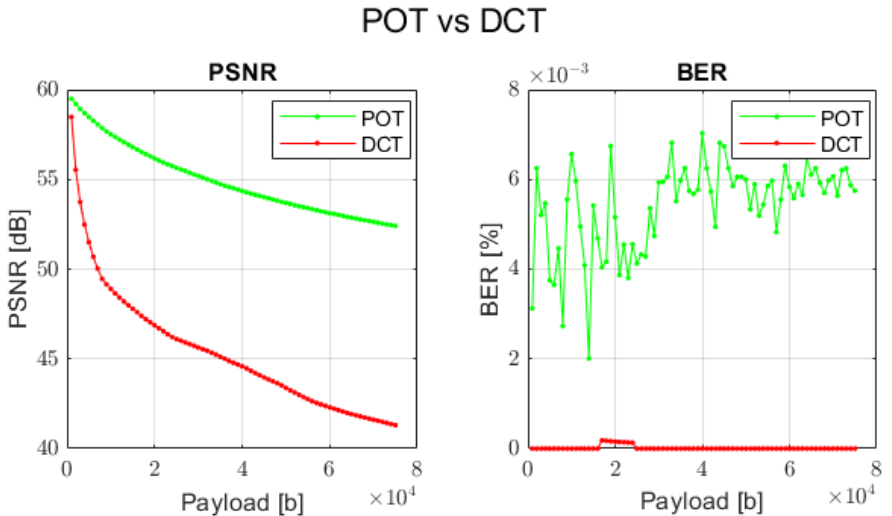
Figure 13. Comparison between proposed orthogonal transform (POT) and DCT transform with respect to PSNR and